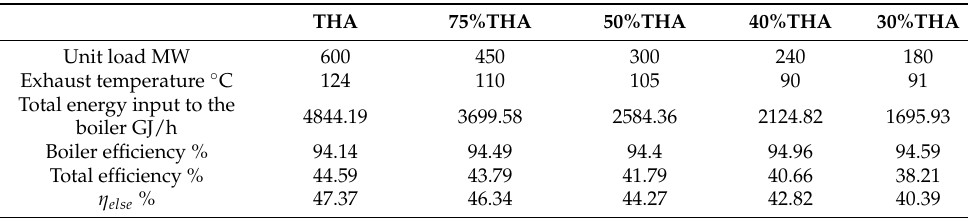
Table 1. Unit parameters under different loads before flue gas extraction.